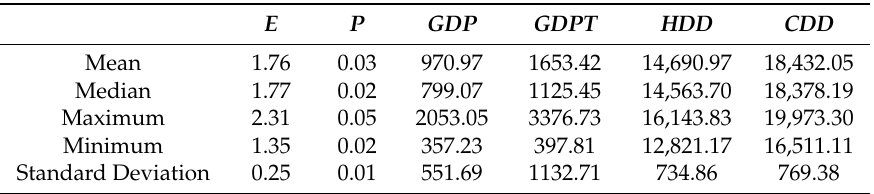
Table 2. Descriptive statistics of the variables over